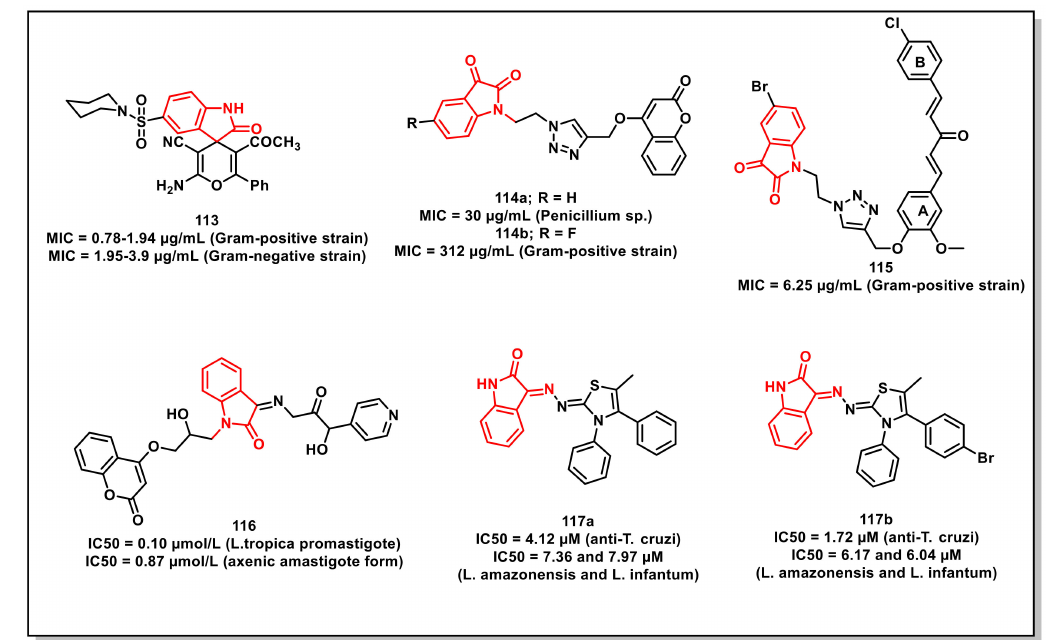
Figure 19. Miscellaneous examples of isatin-based compounds as antimicrobials. Bhagat et al. synthesized and evaluated a series of indolindione-coumarin